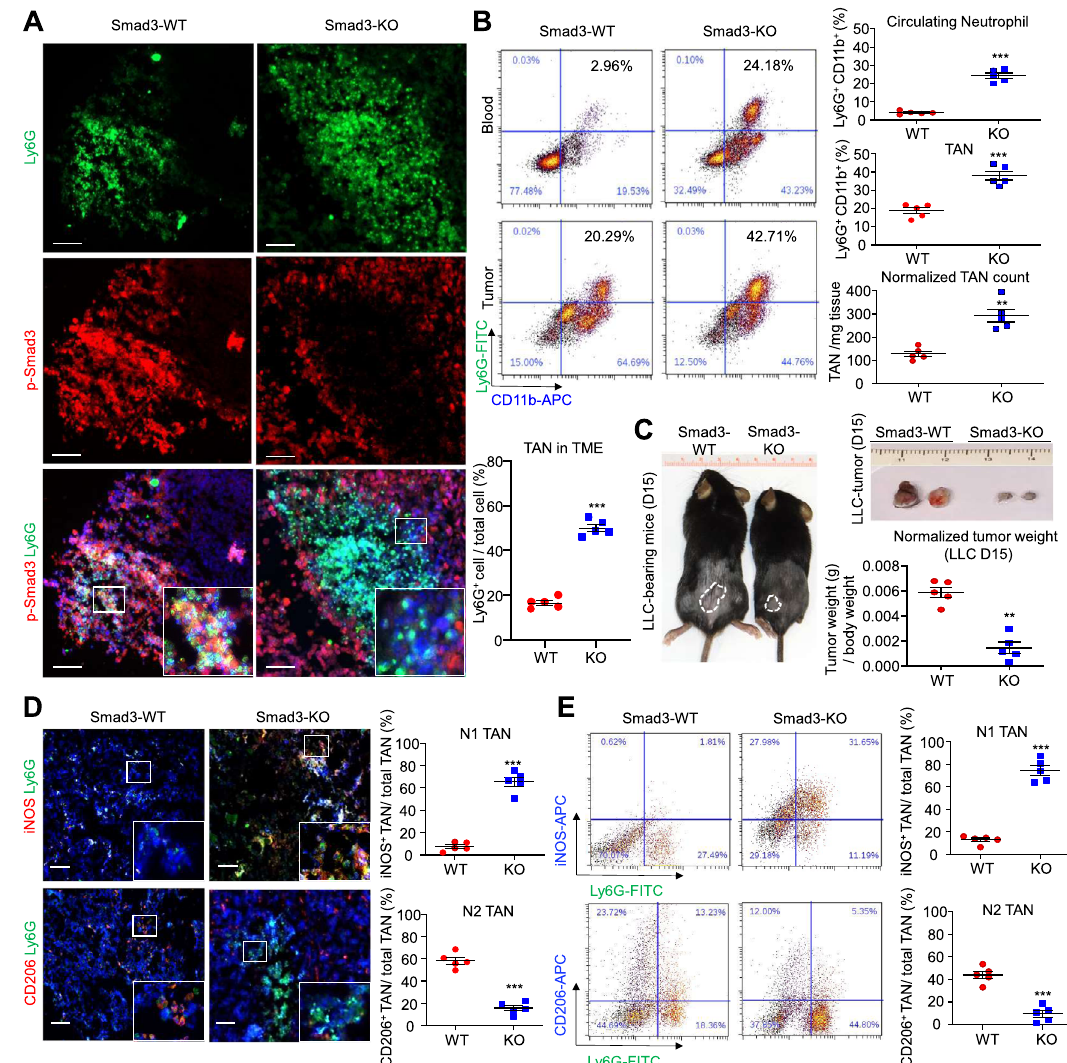
Fig. 2 | Smad3 de fi ciency increases the proportion of N1 TANs in LLC tumors. A Confocalimagingand B fl owcytometry,showanincreaseinLy6G + neutrophilsin the circulation and in the TME of LLC-bearing Smad3-KO mice compared to wild- type(Smad3-WT)controls (** P <0.01, *** P <0.001vs. Smad3-WT,two-tailed t -test). C Smad3-KOmiceshowsmallertumorscomparedtoSmad3-WTcontrolsonday15 (** P <0.01 vs. WT, two-tailed t -test). D Immuno fl uorescence and E fl ow cytometric analysis showed a low proportion of N1 (iNOS + Ly6G + ) and a high proportion of N2 (CD206 + Ly6G + ) phenotype TANs in Smad3-WT mice, which is reversed in Smad3-